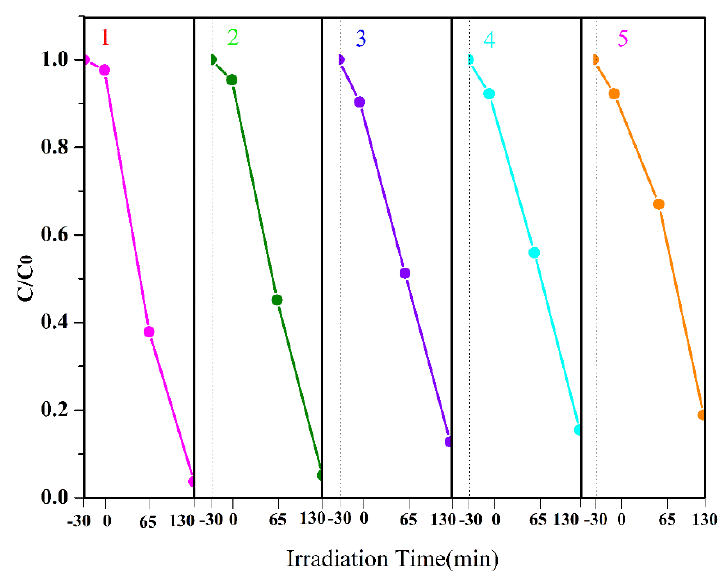
Figure 10. Degradation rate of RhB on Bi 5 O 7 I/Mn x Zn 1 − x Fe 2 O 4 after being recycled.